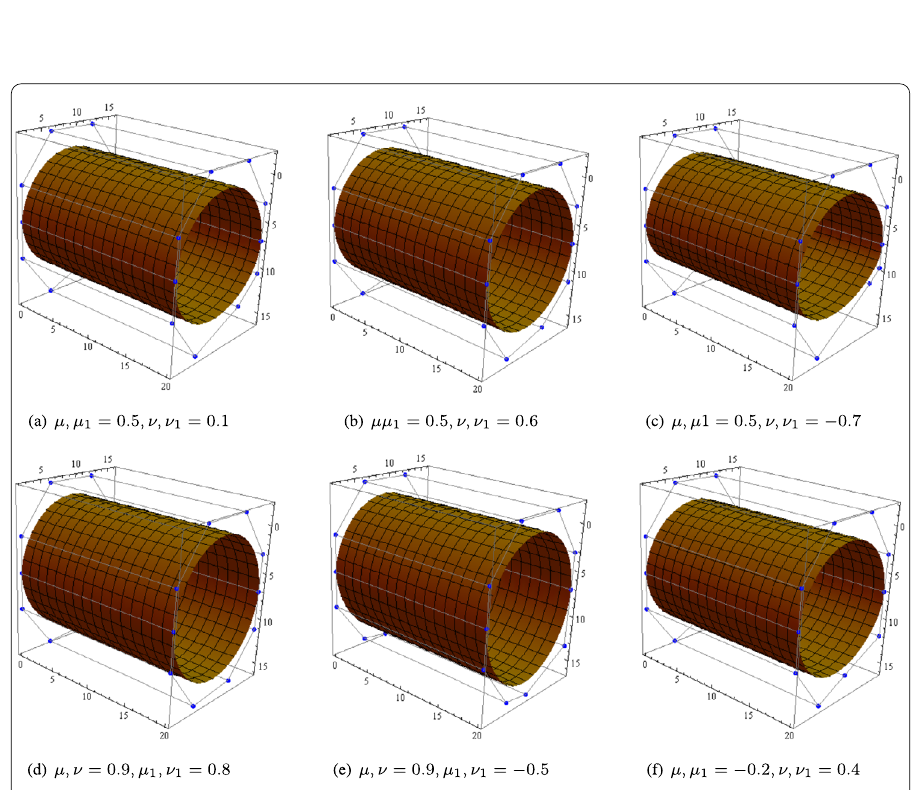
Figure 6 C 2 continuity between two GBT-Bézier